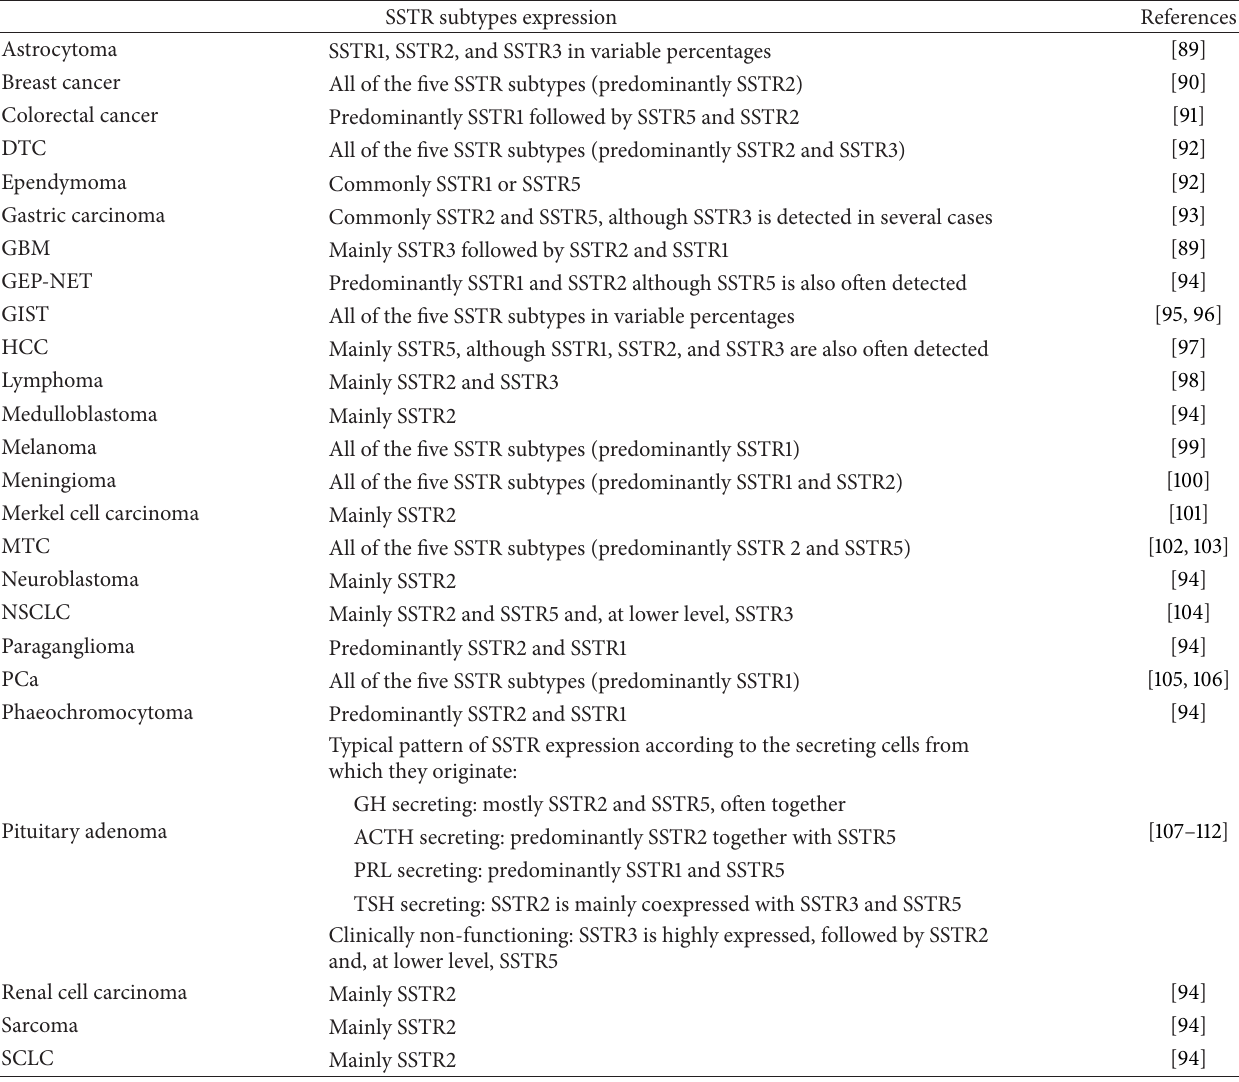
Table 1: Somatostatin receptor subtypes expression in different tumors.